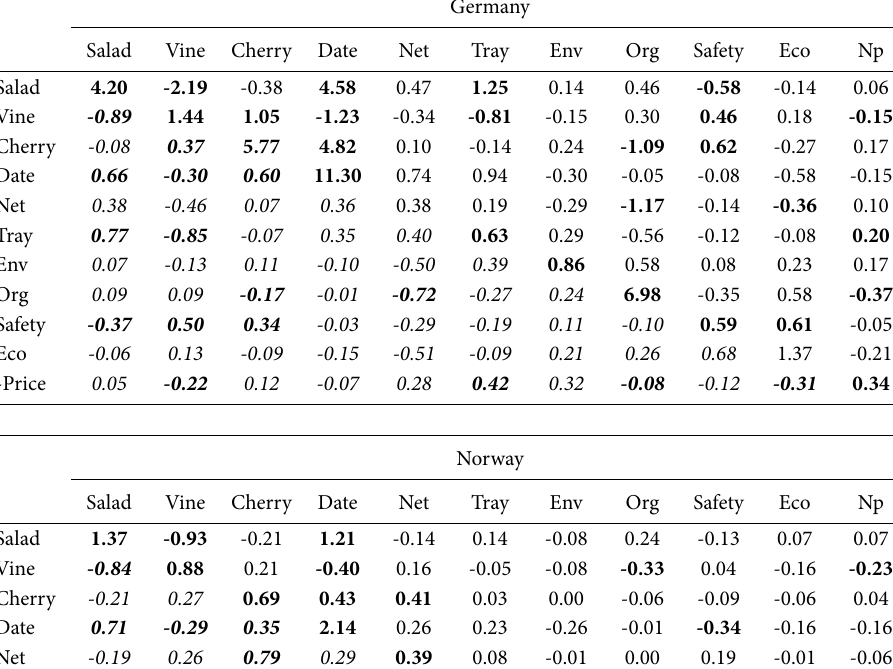
Table 4. Estimates of correlation and covariance matrixes in each country.